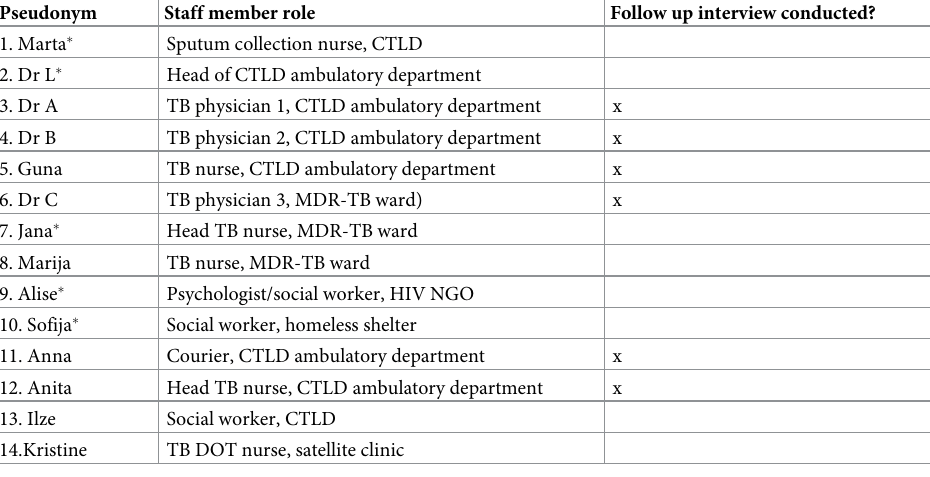
Table 2. Staff interview participants.